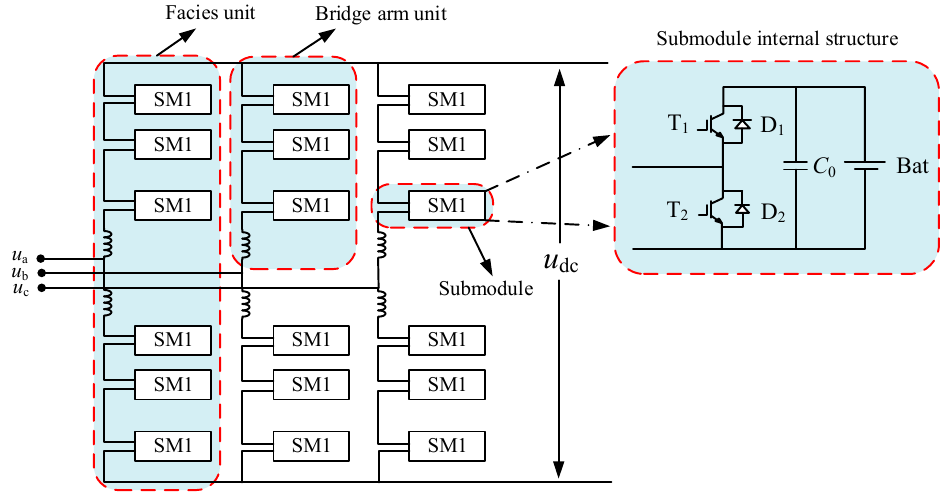
Figure 11. Half-bridge MMC topology [98].